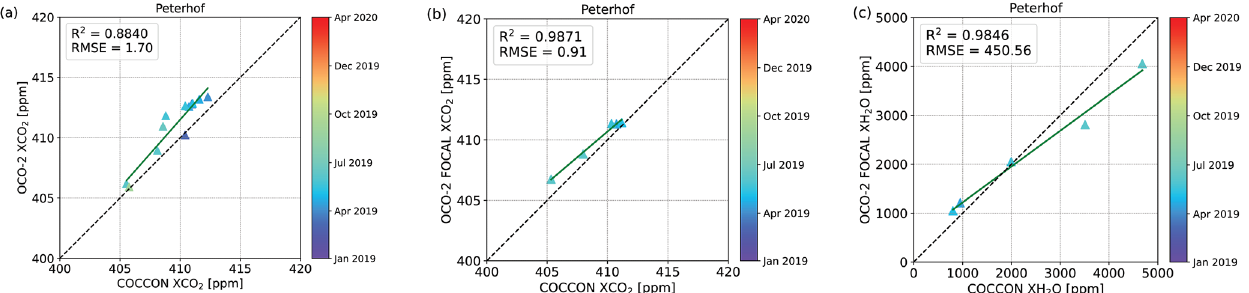
Figure 11. Correlation plots (a–b) between NASA’s operational and the FOCAL OCO-2 product and COCCON for XCO 2 and (c) between OCO-2 FOCAL and COCCON for XH 2 O at Peterhof. All satellite data except XH 2 O were adjusted for the COCCON a priori profile (TCCON a priori profiles were